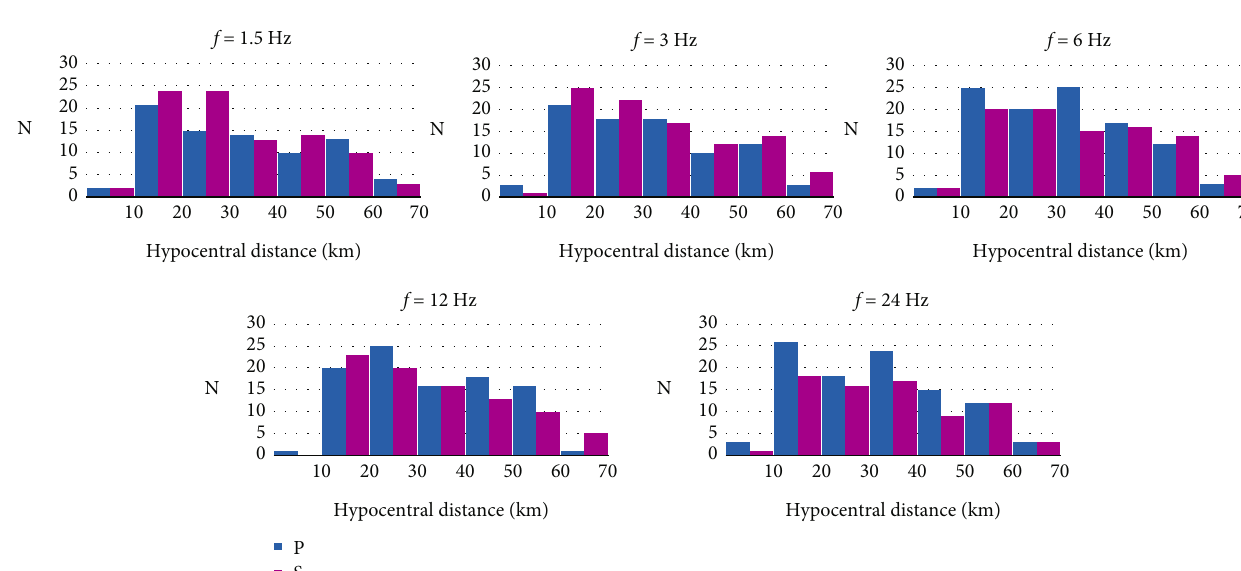
Figure 4: The number of earthquake records versus hypocentral distance used to estimate Q